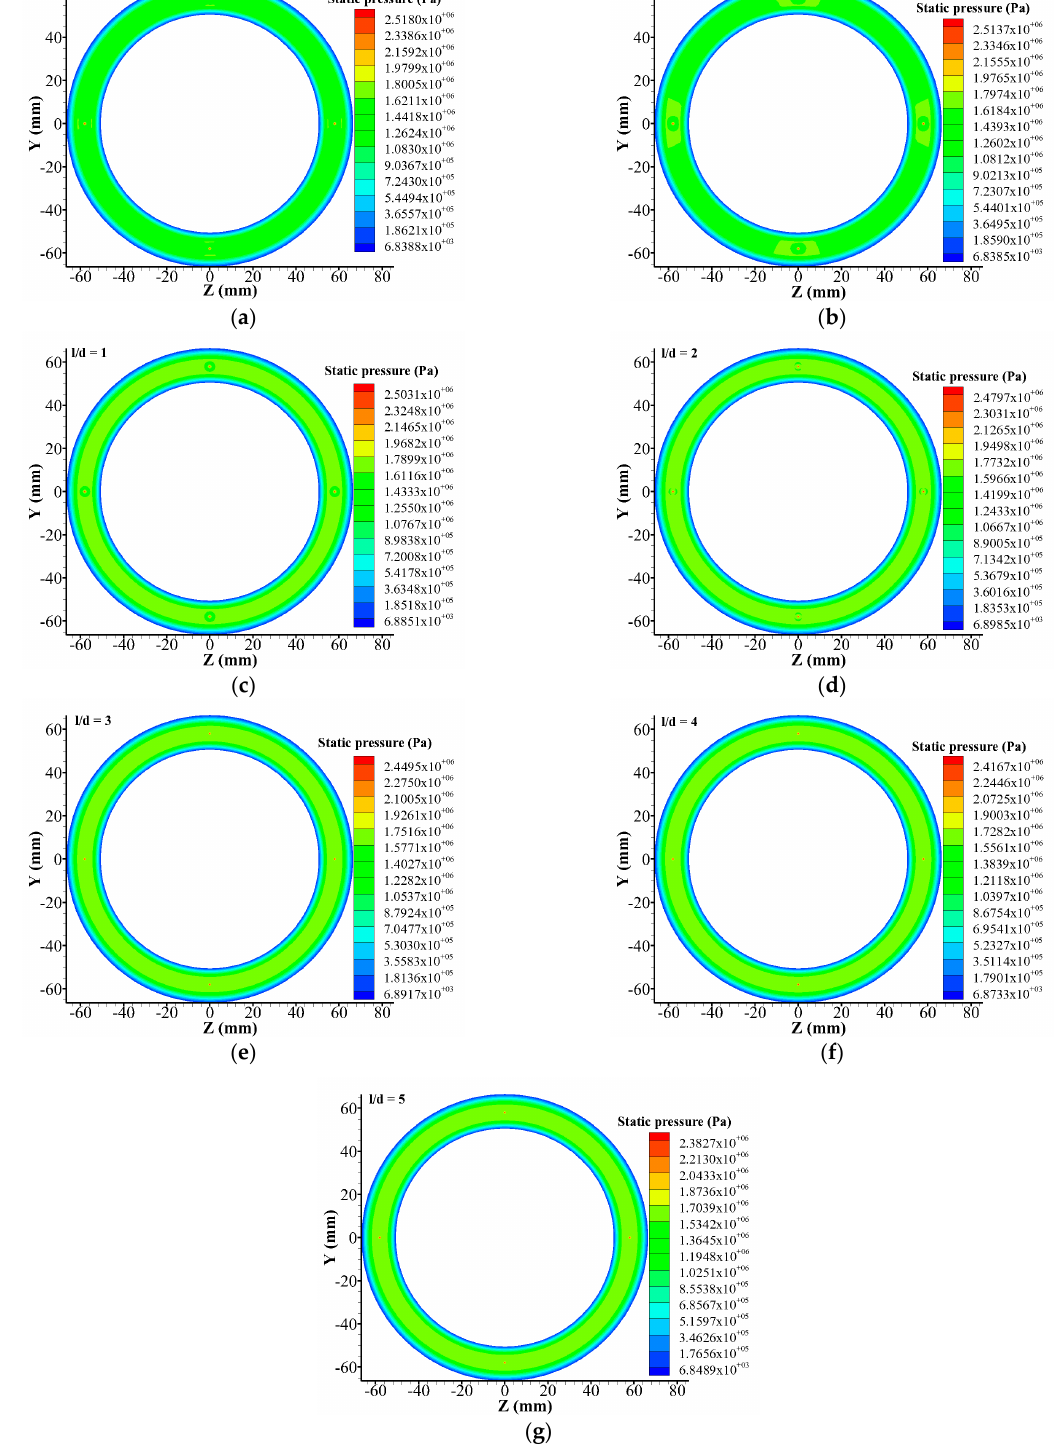
Figure 11. Pressure distributions of wall S for various OLDRs. ( a ) l / d = 0.25; ( b ) l / d = 0.5; ( c ) l / d = 1; ( d ) l / d = 2; ( e ) l / d = 3; ( f ) l / d = 4; ( g ) l / d = 5.